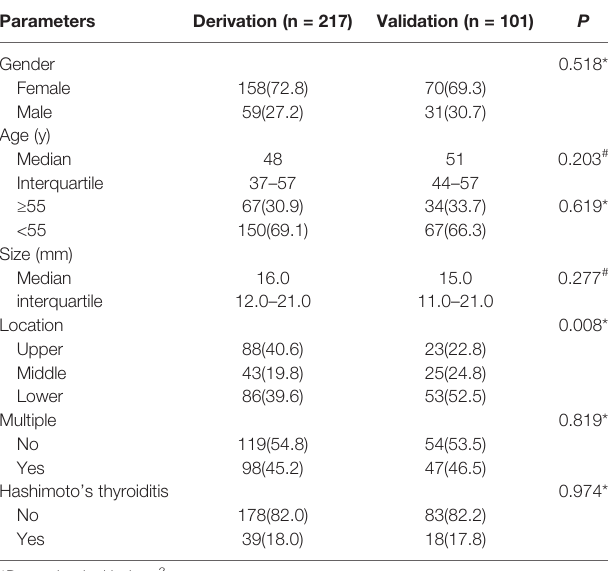
TABLE 1 | Basic characteristics in the derivation and validation cohorts.